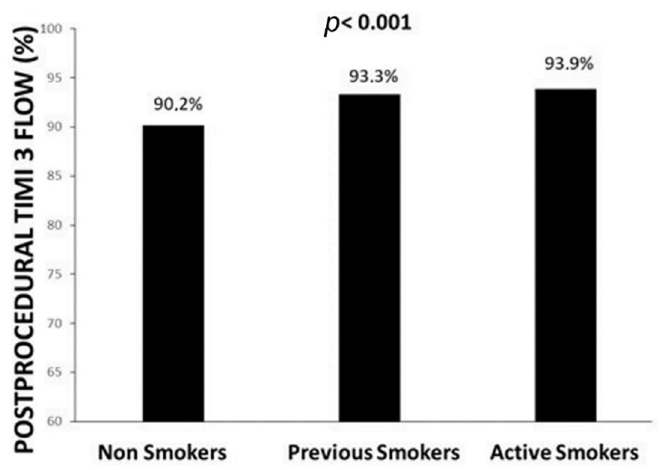
Figure 1. Bar graphs show the association between smoking status and postprocedural TIMI flow. Smokers had a significantly lower in-hospital (Figure 2) and 30-day (Figure 3) mor- tality compared with non-smokers and previous smokers; this was confirmed in both pre-COVID ( p < 0.001) and COVID era ( p < 0.001) and in young ( p < 0.001) and older